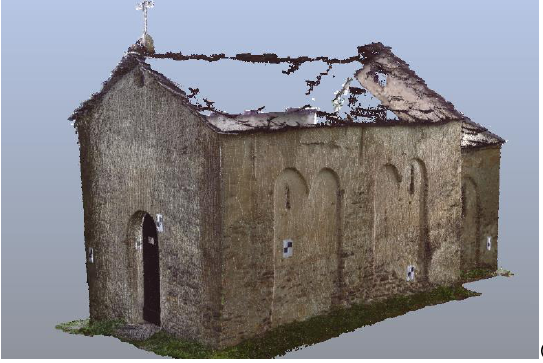
Figure 8. Original TLS point cloud (a), cleaned TLS point cloud of the Chapel